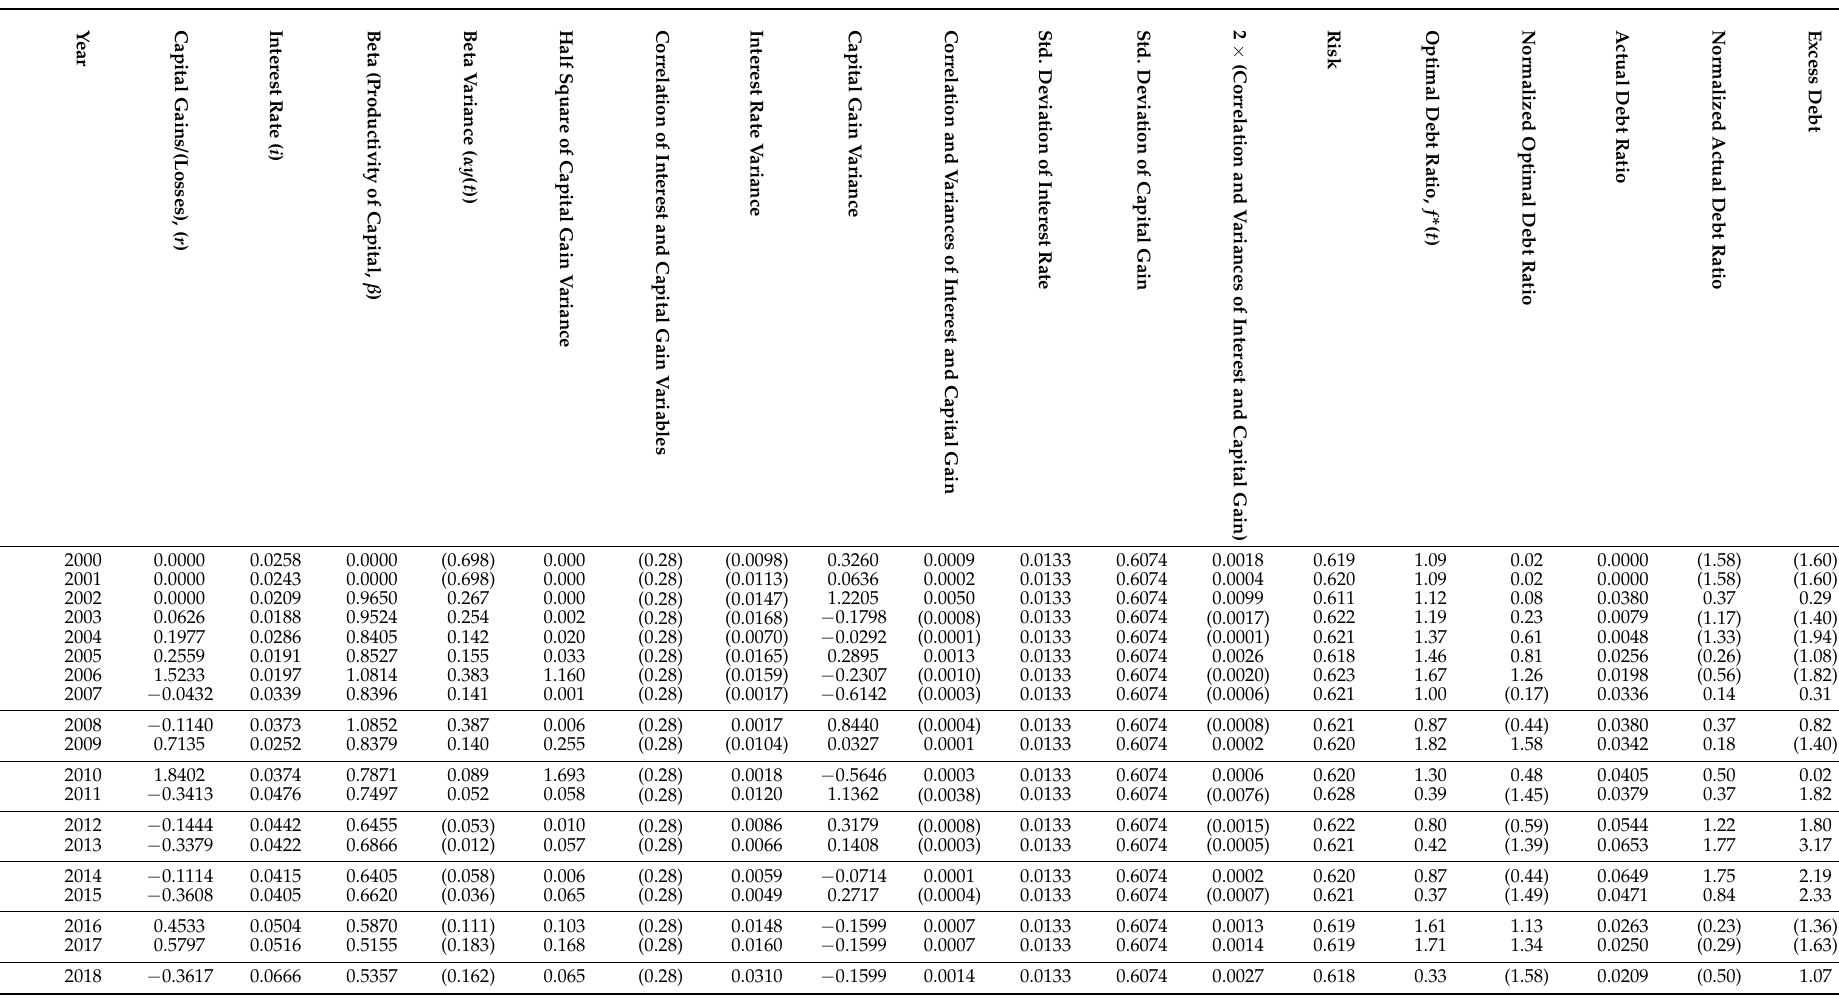
Table A7. Calculations of Optimal and Excess Debt: Bank CIMB